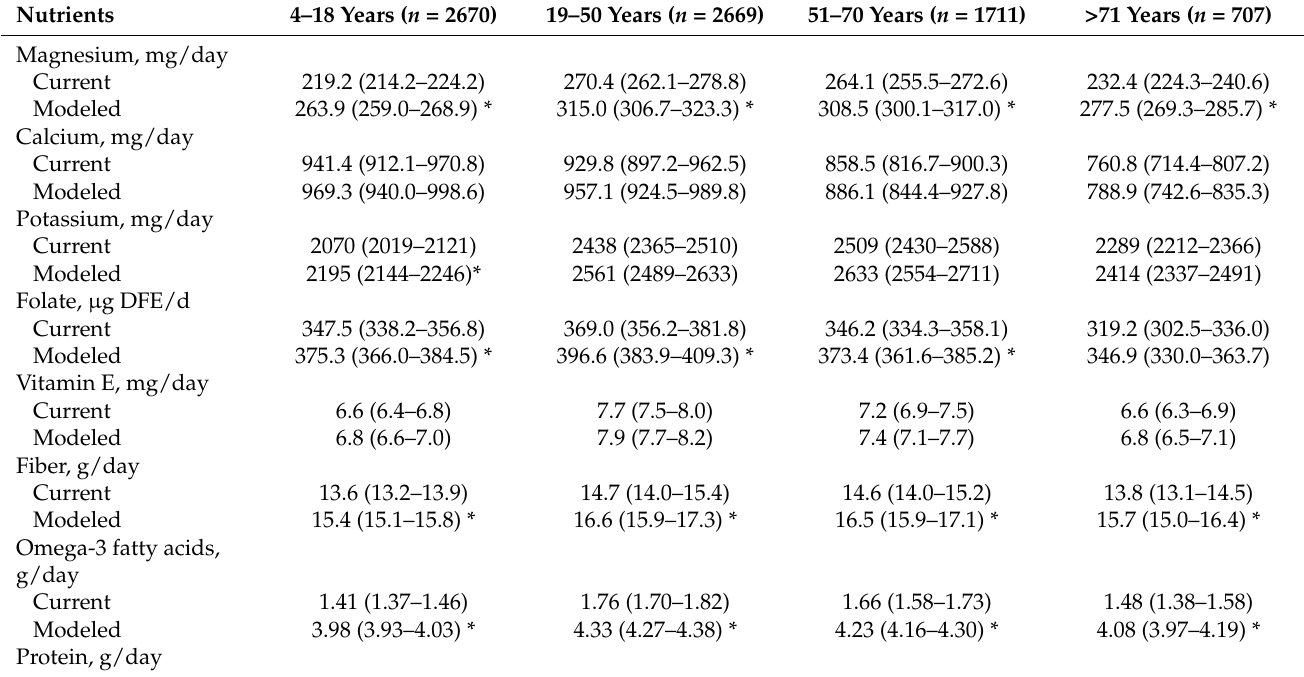
Table 2. Under-consumed nutrients, protein intake, and energy intake for usual (current) and modeled dietary intakes (addition of 1 ounce of walnuts, mean (95%